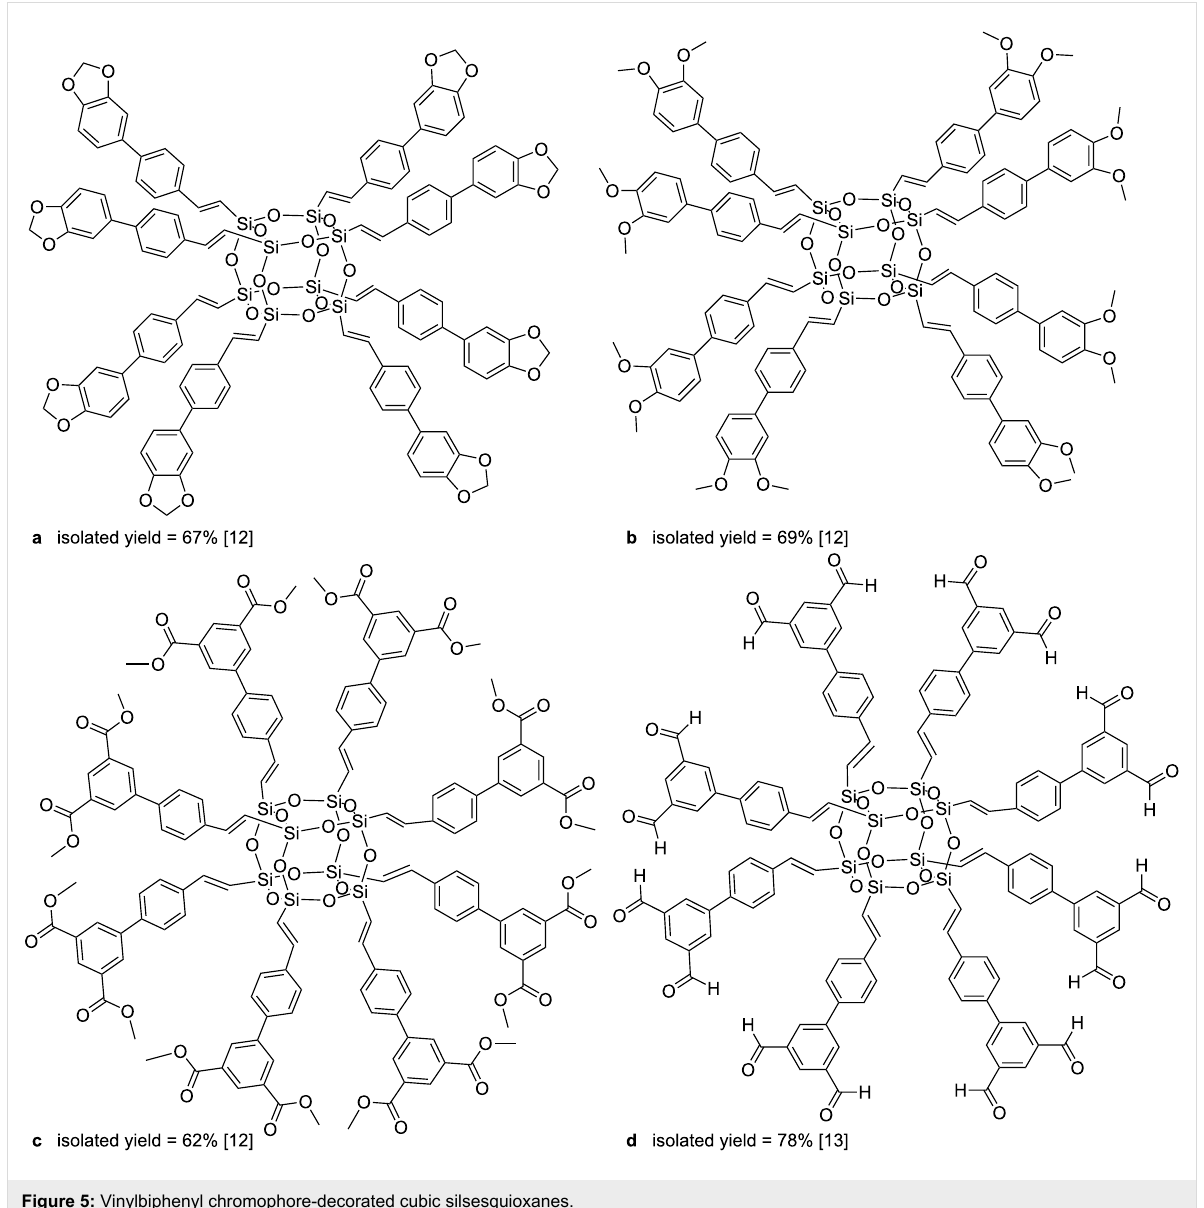
acter of the acid and the directionality of the hydrogen bond pattern of the acid